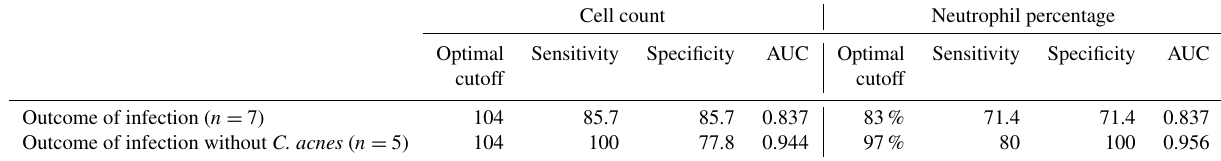
Table 2. ROC values. Cell count Neutrophil percentage Optimal Sensitivity Specificity AUC Optimal Sensitivity Specificity cutoff cutoff Outcome of infection ( n =